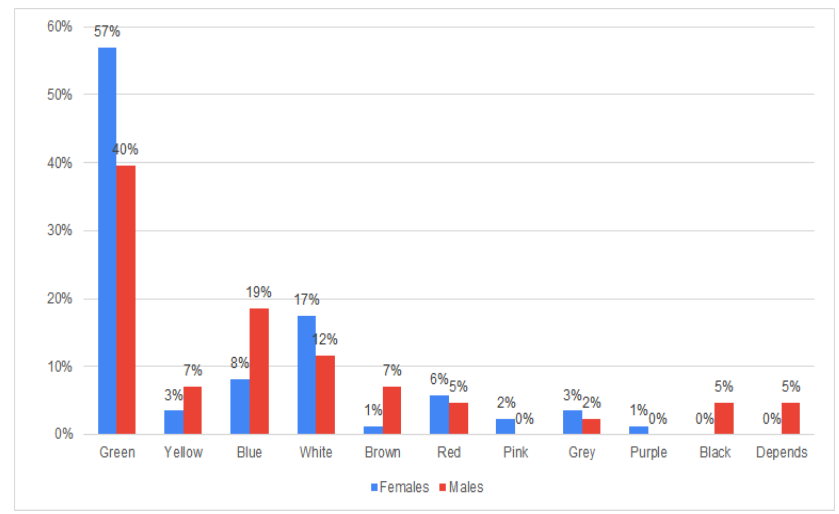
Figure 4. Colour preference by gender.